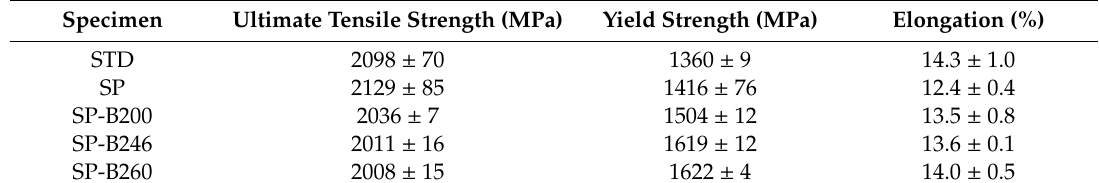
Table 4. Mechanical properties obtained from the tensile test of 4340M steel.